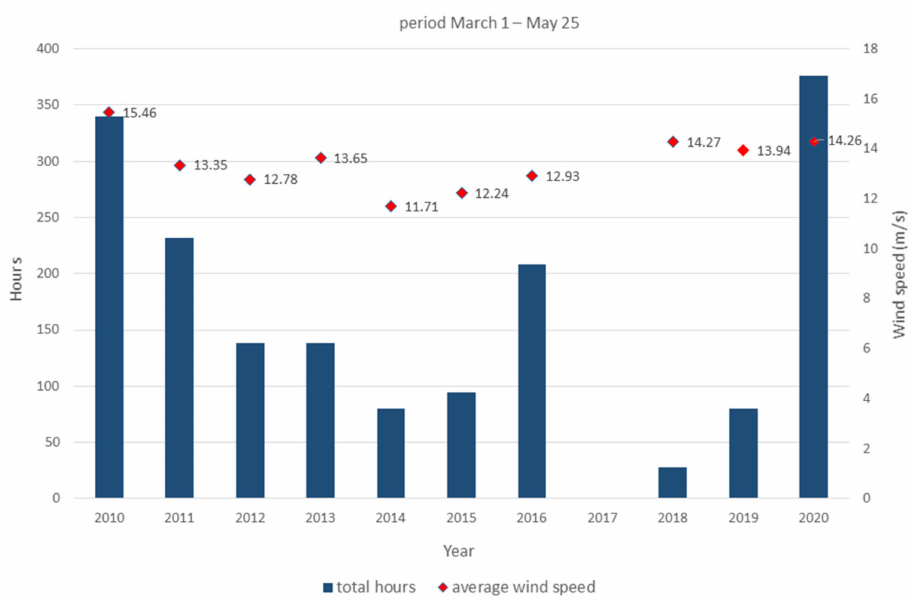
Figure 2. Total hours and Bora wind speed calculated for the time interval from 1 March to 25 May, in the period 2010–2020 (data from the oceanographic buoy VIDA, https://www.nib.si/mbp/en/). Temperature (+20 ◦ C), photoperiod (15:9 h of light:dark cycle), and measured